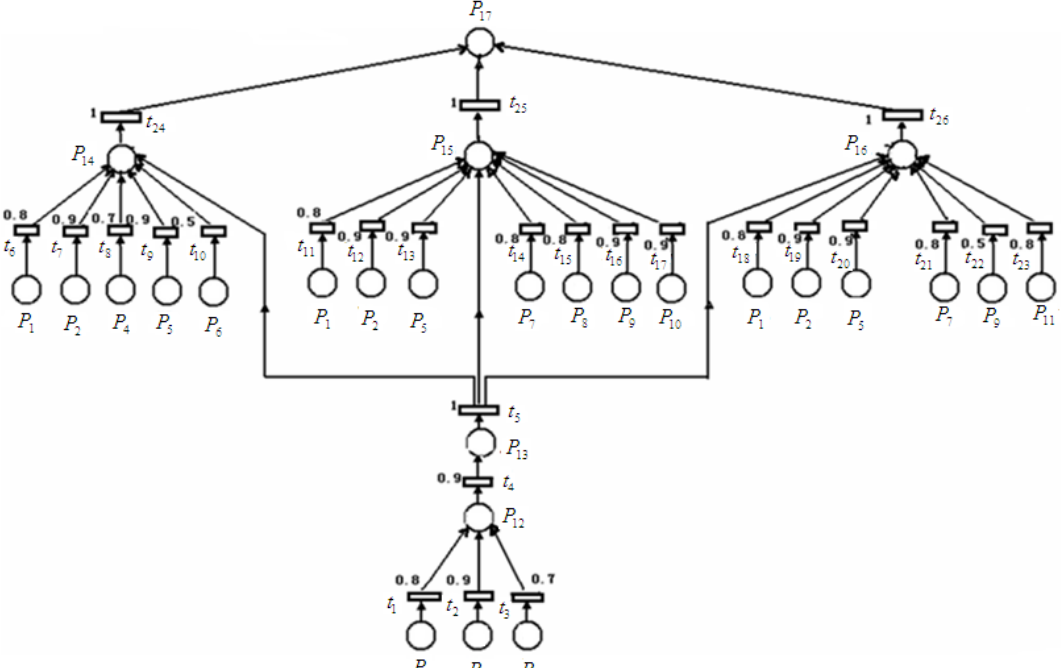
Figure 9. Fault Petri net model of a hydraulic variable pitch